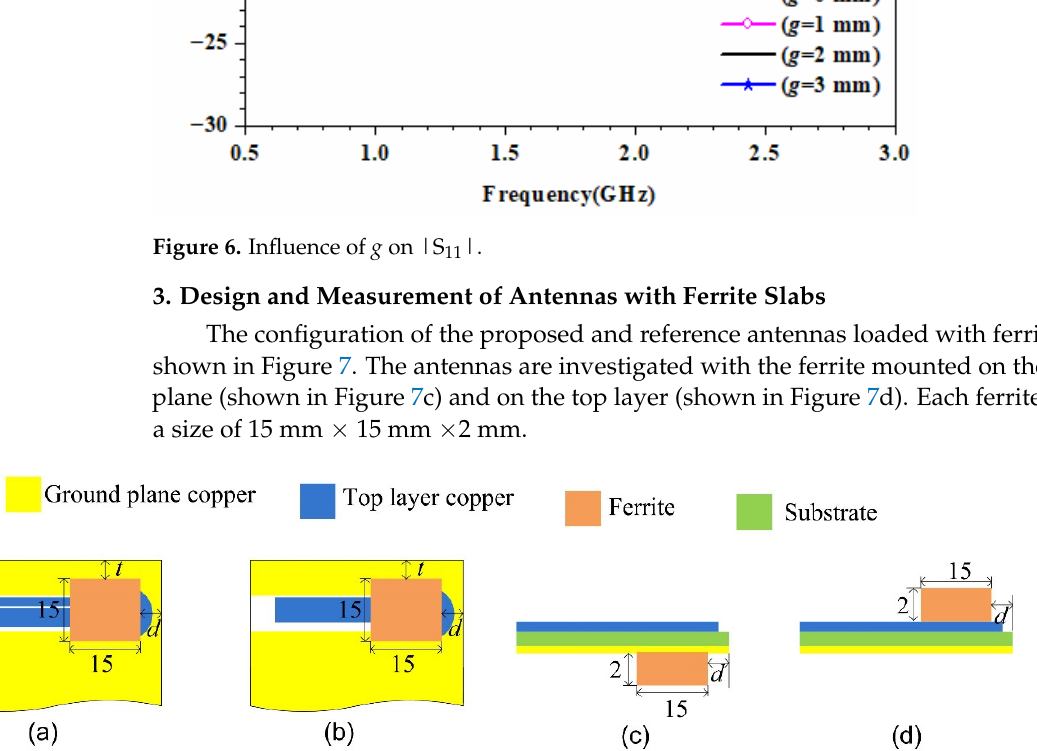
Figure 7. Configuration of the proposed, reference antenna loaded with ferrite slab (unit: mm). ( a ) Top view of the proposed antenna loaded with ferrite slab. ( b ) Top view of the reference antenna with ferrite slab. ( c ) Side view in the case of ferrite slab mounted on the ground plane. ( d ) Side view in the case of ferrite slab mounted on the top layer.